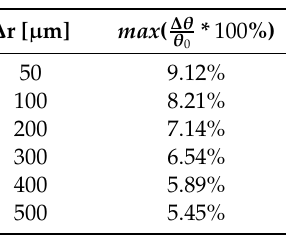
Table 4. The maximal percentage relative error ( ∆Θ / Θ ) · 100% of the proposed algorithm accuracy in the determination of the misalignment angles performed for di ff erent ∆ r-parameter